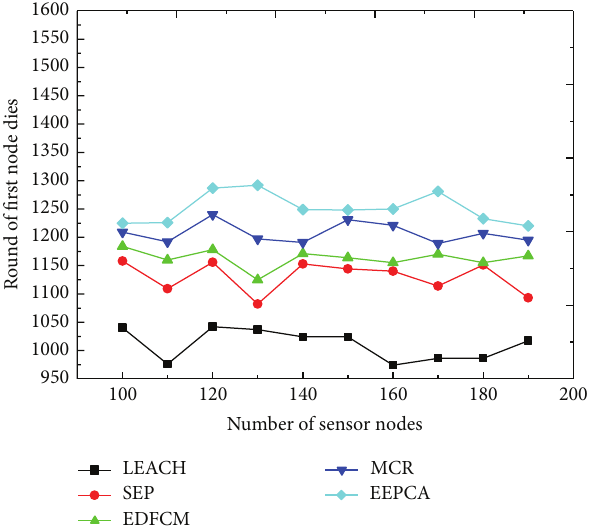
Figure 8: Round of first node dies with varying fraction of the two types of nodes.